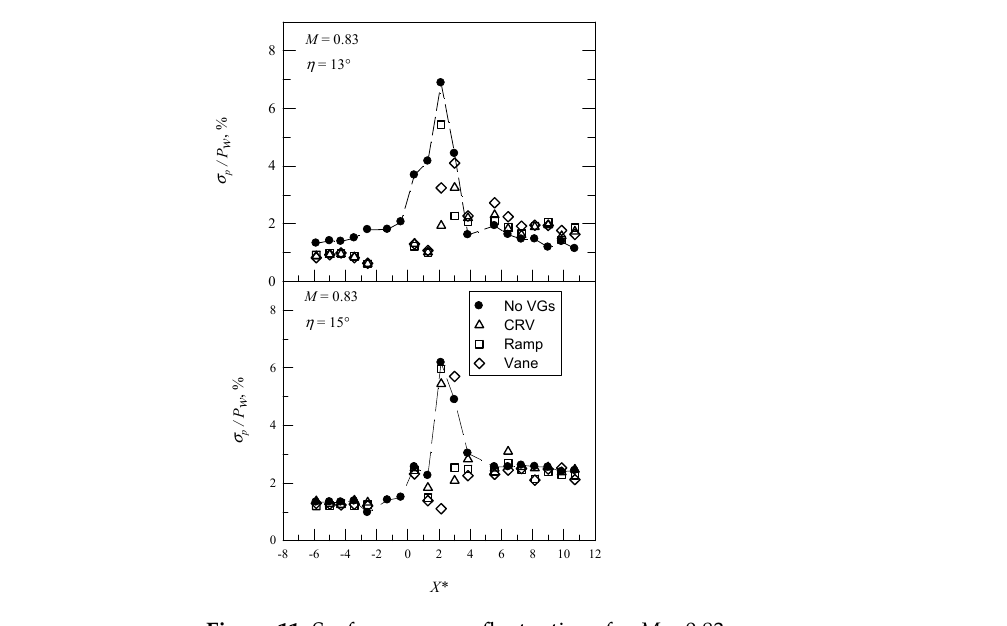
Figure 11. Surface pressure fluctuations for M = 0.83. Verma and Manisankar [18] showed that there is a reduction in ( σ p / P w ) max , when MVGs are present. This is also true for the test configuration in this study. If Vane MVGs are used, the location of ( σ p / P w ) max moves downstream, which corresponds to (P w / P o ) min (or M peak ) in Figure 8. For η = 15 ◦ , the effect of MVGs is less significant. For M = 0.89, the distributions of surface pressure fluctuations are shown in Figure 12. These are similar to those for M = 0.83, but the location of ( σ p / P w ) max moves farther downstream ( X * = 3.86), which corresponds to the P w / P o distributions that are shown in Figure 9.